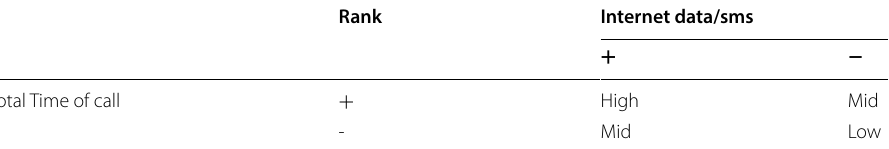
with (high, low) loyalty